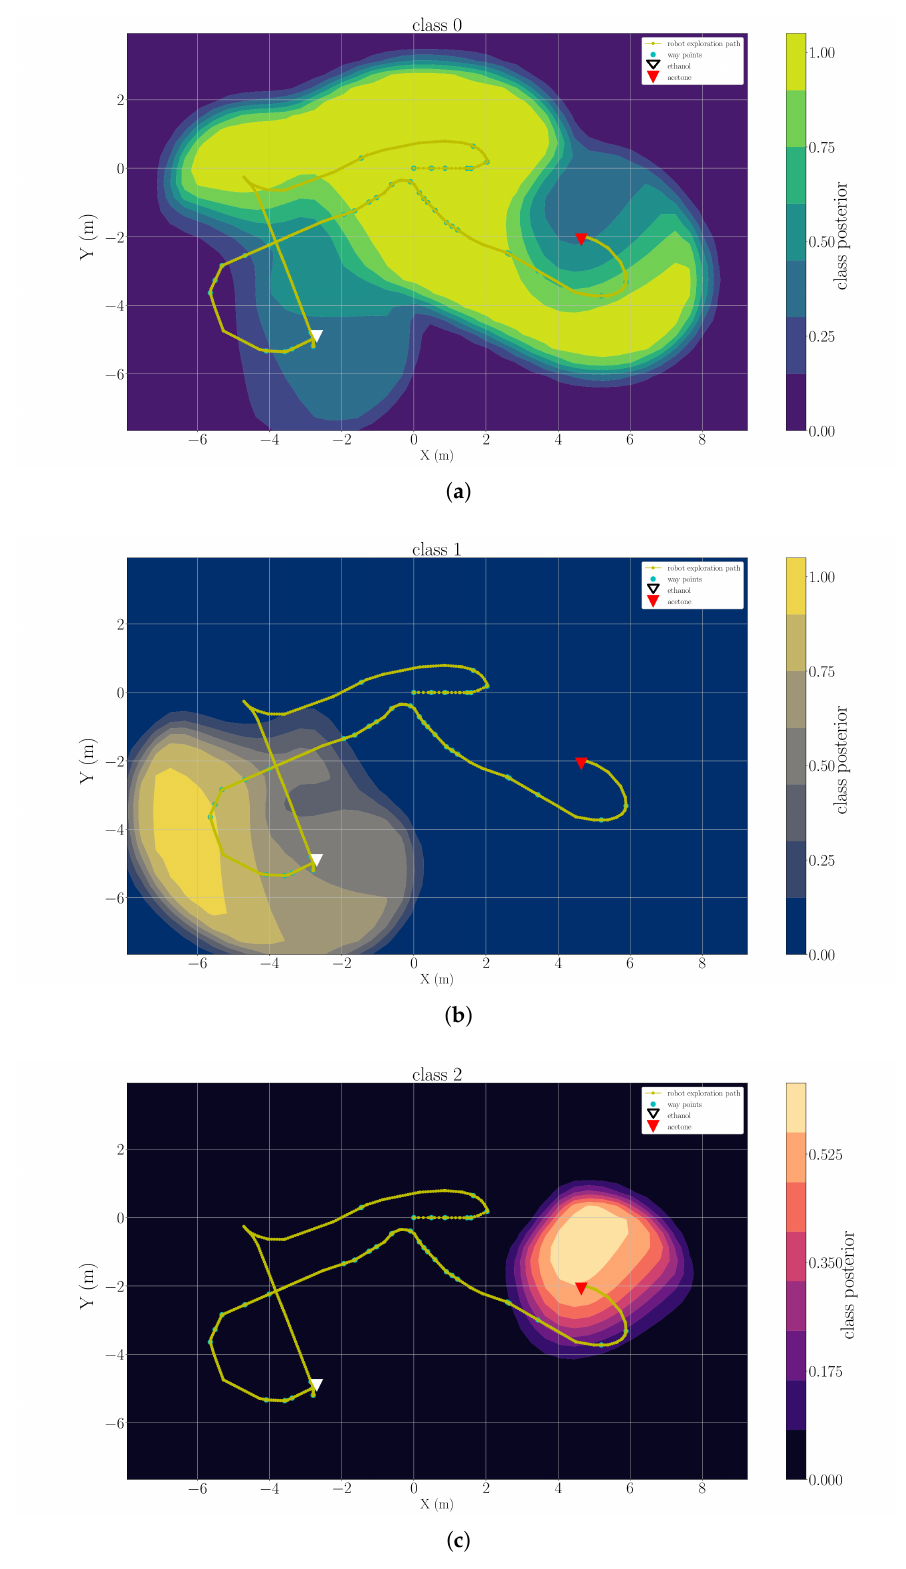
Figure 12. A snapshot of the classification map learned for clean air ( a ), ethanol ( b ) and acetone ( c ) in the trial Experiment